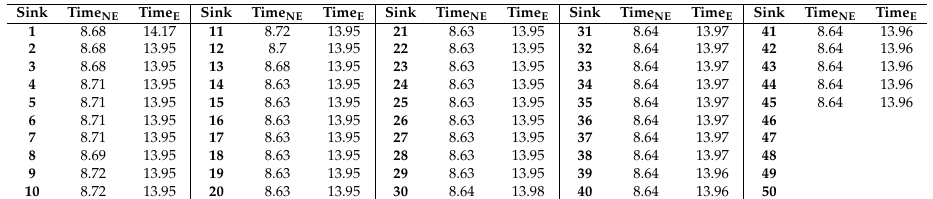
Table A12. Scenario 2: transmission times (in s) for each sink all over the transmission line. (Distance between poles is equal to 300 m, κ = 45, η = 1, NE means no encryption, E means encryption.)